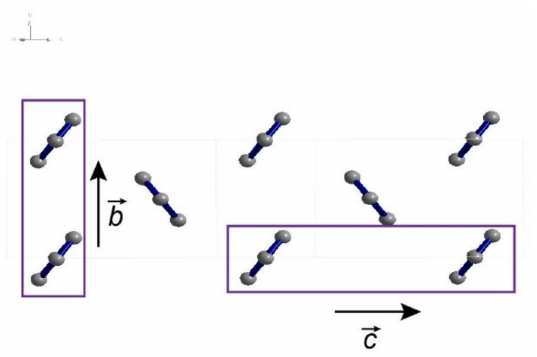
Figure 4. Correlation of packing scheme along different crystal axes. Schematics of hexaphenyl stacking patterns along the b - and c